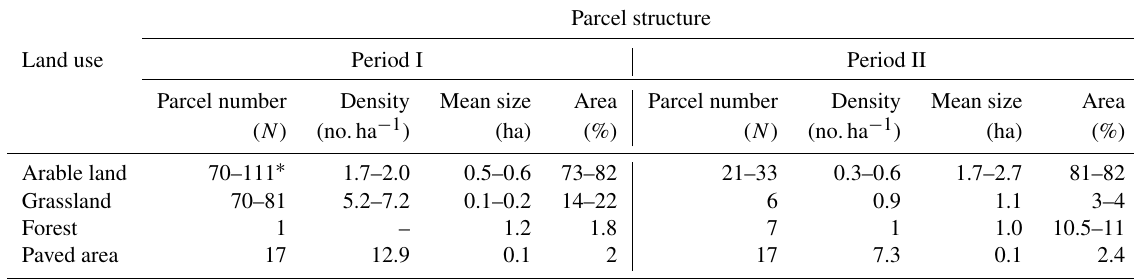
Table 1. Parcel and land use statistics for periods I and II: Period I represents land use for the years 1946–1949, and Period II represents land use for the years 2007–2012. N is the number of parcels for a given land use, density is the number of parcels per hectare, and mean size represents the mean area of parcels with a particular land use.